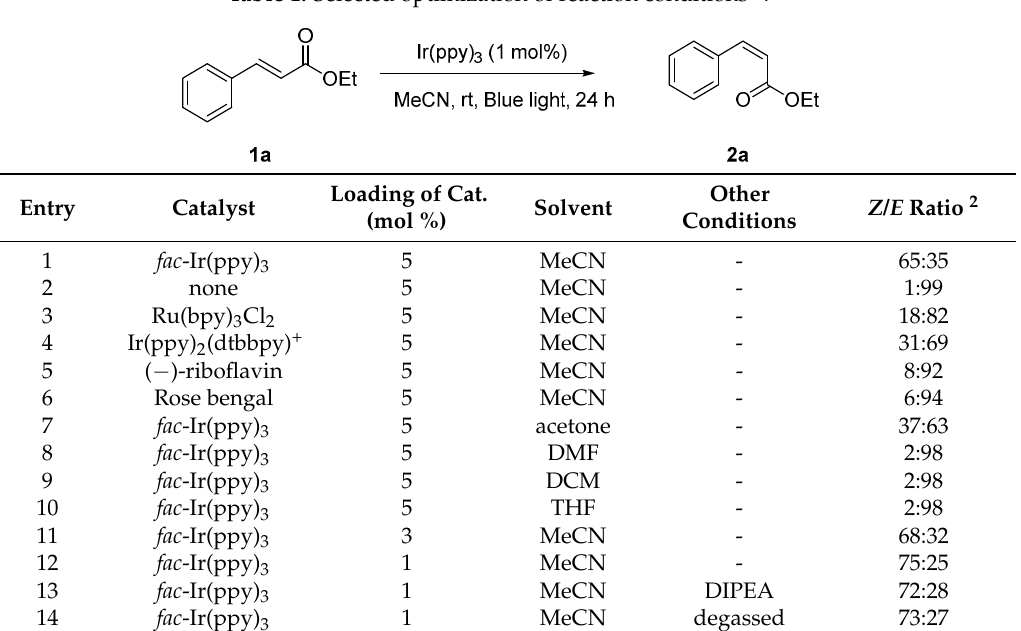
Table 1. Selected optimization of reaction conditions 1 .